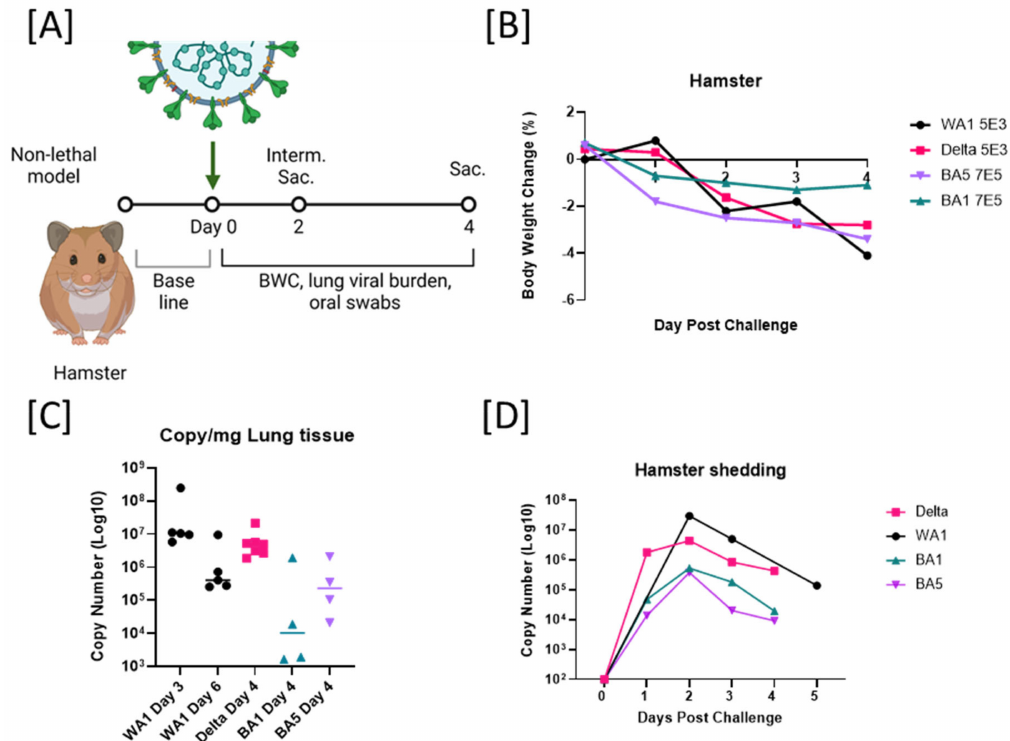
Figure 2. Host-dependent pathogenicity of B.1.617.2 (Delta), WA1/2020 and B1.1.529 (BA.1) and BA.5 Omicron in hamster. ( A ) Schematic diagram of SARS-CoV-2 infection and experimental de- sign. Interim Sac = scheduled interim sacrifice/euthanasia. Sac. = final euthanasia. Created with BioRender.com. Animals were intranasally inoculated with 5 × 10 3 TCID 50 /animal of SARS-CoV-2 WA1 or B.1.617.2/Delta or 6.5 × 10 5 TCID 50 /animal of BA.1 or BA.5 on day 0. Body weights before challenge were used to establish baseline. Survival, body weight changes (BWC), oral swabs, or